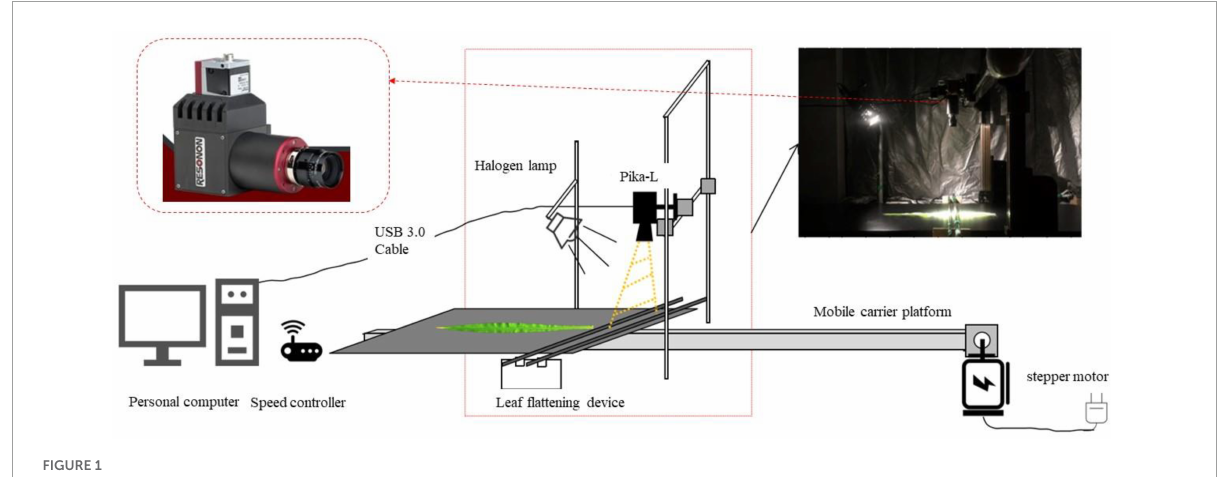
FIGURE1 Hyperspectral images acquisition